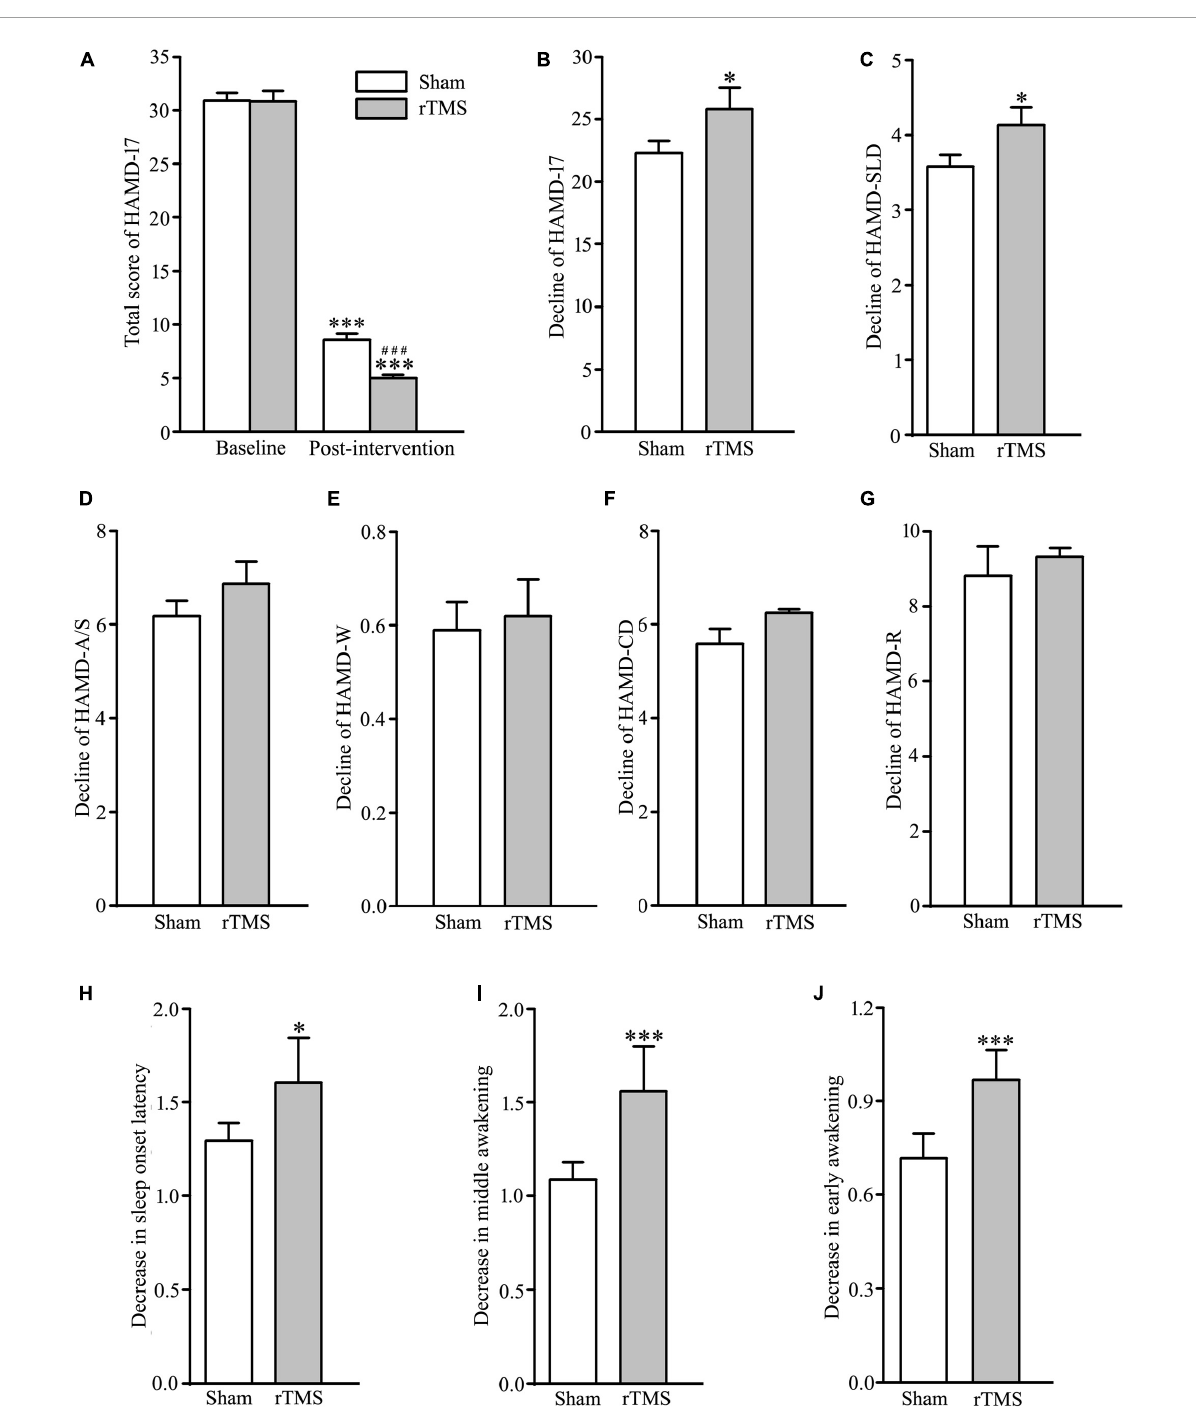
FIGURE2 Effect of repetitive transcranial magnetic stimulation (rTMS) on depression scores measured with 17 items Hamilton depression rating scale (HAMD-17) at baseline and 4-week after bilateral rTMS or sham treatment in patients with major depressive disorder (MDD) combined with psychotropic drugs. (A) Total score of HAMD-17 at baseline and 4 weeks after treatment. (B) Change in a total score of HAMD-17 from baseline to post-intervention at 4 weeks. (C–G) Change in scores of five factors in HAMD-17; HAMD-SLD (C) , HAMD-A/S (D) , HAMD-W (E) , HAMD-CD (F) , and HAMD-R (G) . (H–J) Change in scores of three items in HAMD-SLD; sleep onset latency (H) , middle awakening (I) , and early awakening (J) . rTMS group significantly different from the sham group was marked by asterisks. ∗∗∗ p < 0.001, compared with the baseline (A) ; ### p < 0.001, compared with the sham group at 4 weeks after treatment; ∗ p < 0.05, ∗∗∗ p < 0.001, compared with the sham group (B–J) . Graphs show mean ± SEM; n =